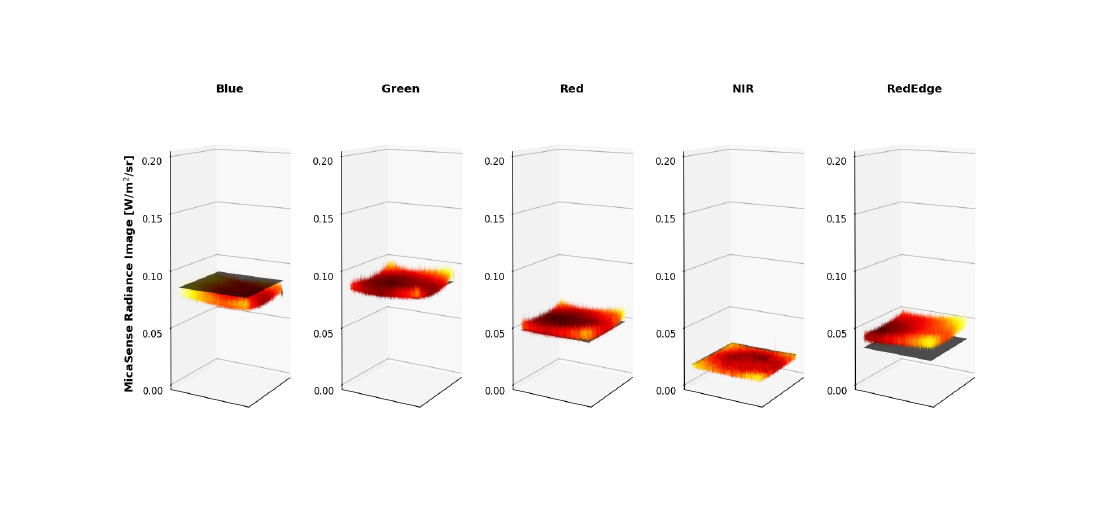
Figure 19. Example MicaSense radiance imagery shown as 3-D images. ASD reference is shown as a black 2-D image. Imperfections of MicaSense methodology is noticeable in the magnitude (radiance calibration coefficients) and in the edges (vignette correction) of the radiance images.